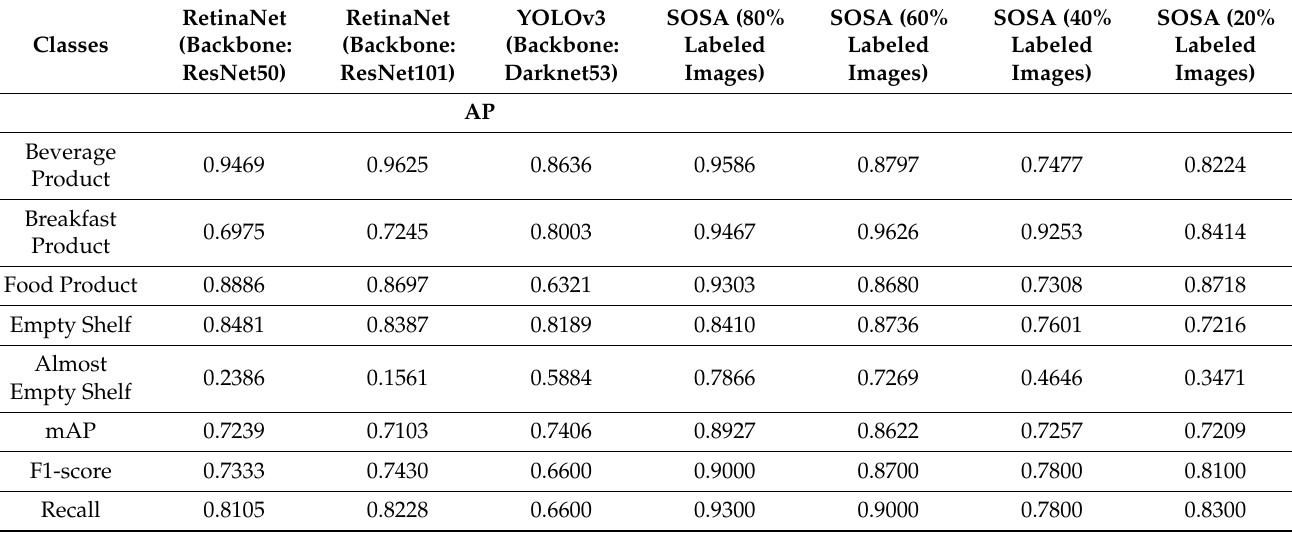
Table 4. Comparison of accuracies between SOSA and existing